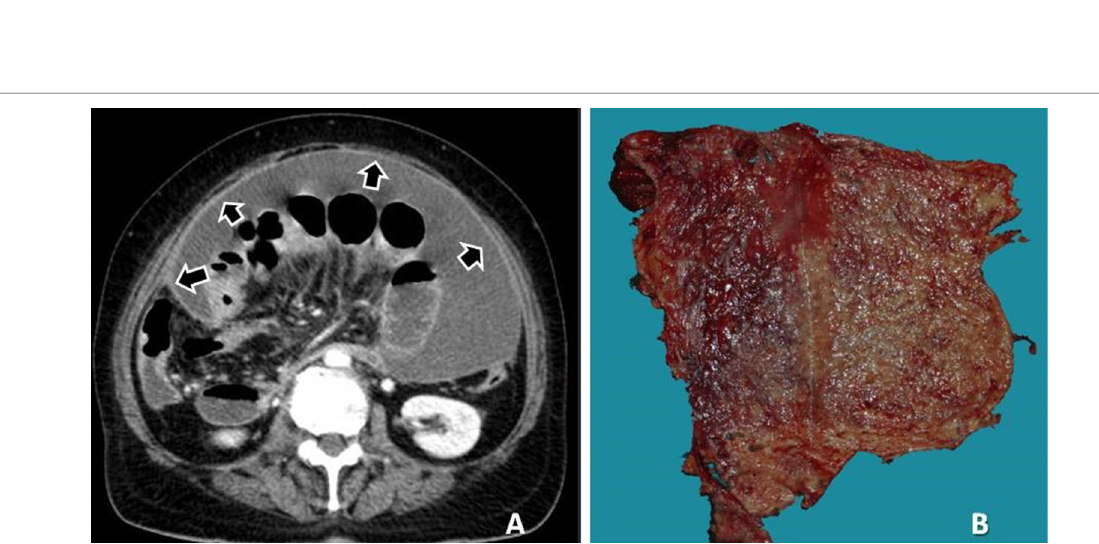
Fig. 5 a CT enhanced image delineates thickened and enhanced peritoneum (arrows) and ascites. b Surgical specimen of the excised peritoneum